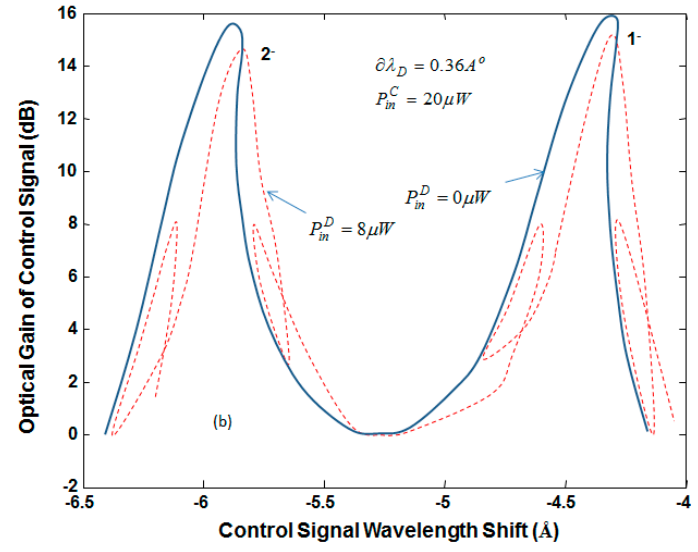
Figure 4. Optical gain of control signal as a function of control wavelength shift at fixed input